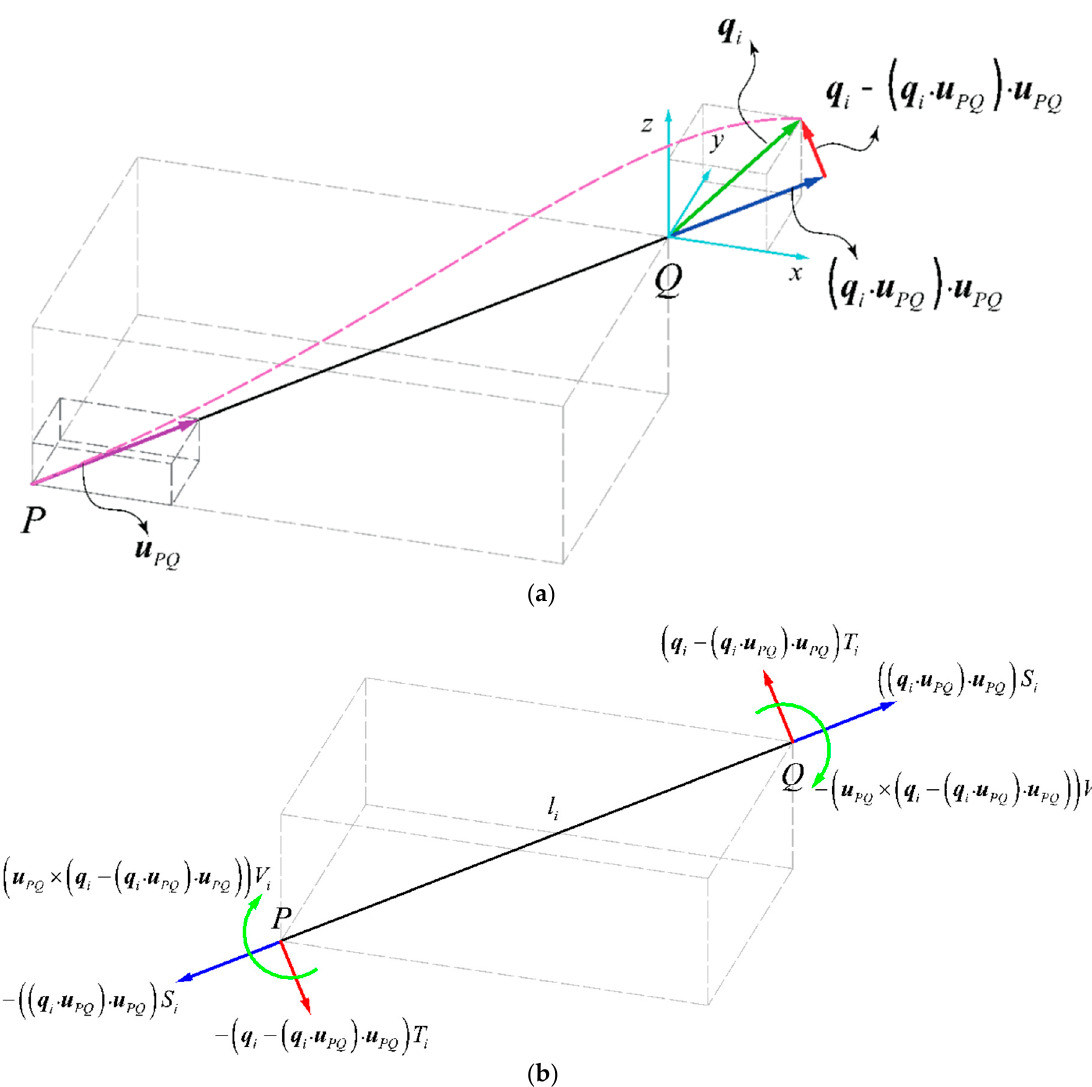
Figure 5. General deformation of a strut due to 𝑞 (cid:3036) = 1 ( a ) magnitude of deformations and ( b ) re- sultant forces and